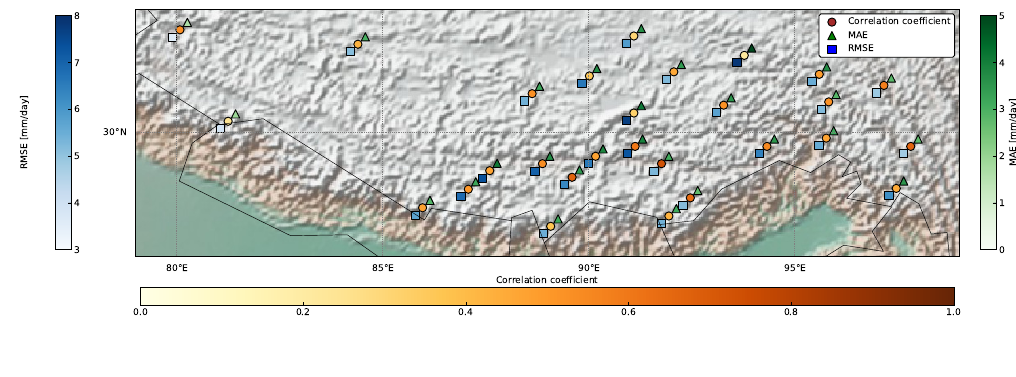
Figure 11. Spatial distribution of validation measures correlation coefficient (yellow/brown circles), MAE (green triangles), and RMSE (blue